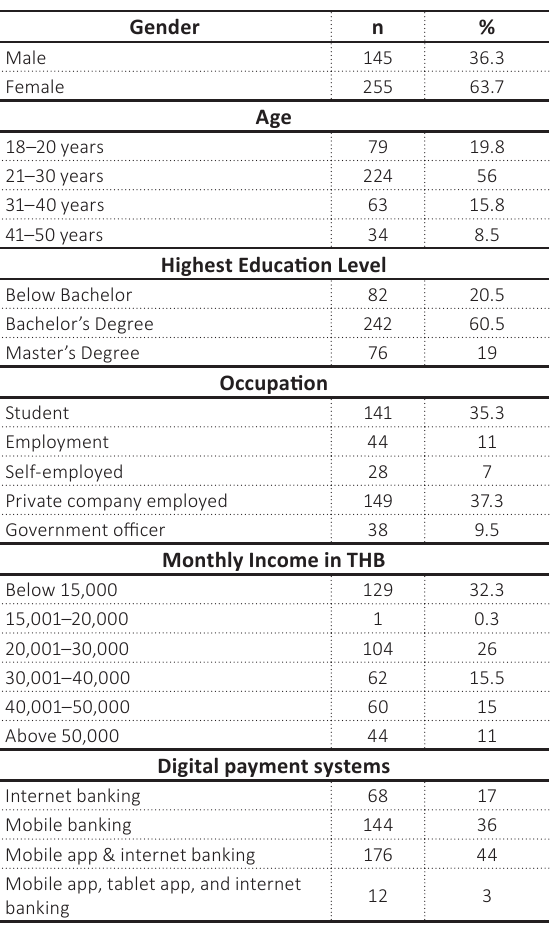
Table 1. Demographics and respondent adoption of digital